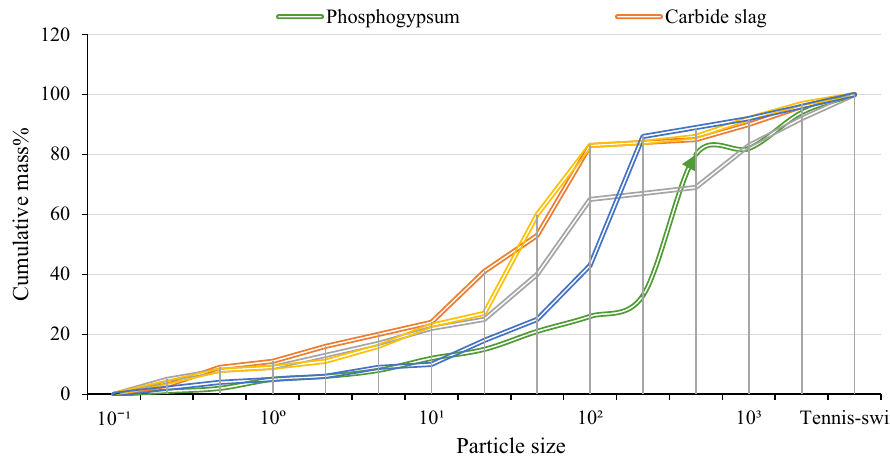
Figure 5. Particle size distribution curves of converter, steel slag, carbide slag, and